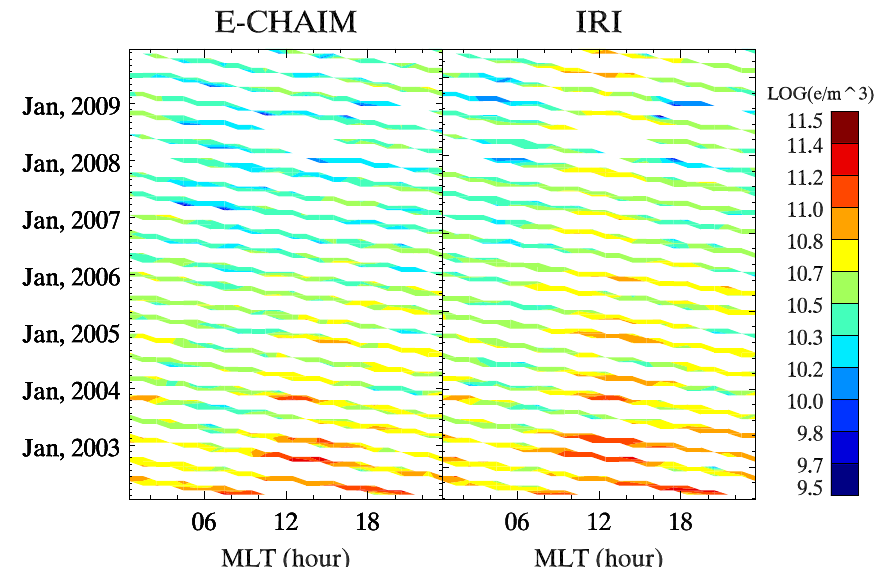
Fig. 14. Log contours of E-CHAIM (left) and IRI (right) monthly RMS electron density errors with respect to CHAMP in situ measurements from a bin between 55 (cid:1) N and 65 (cid:1)